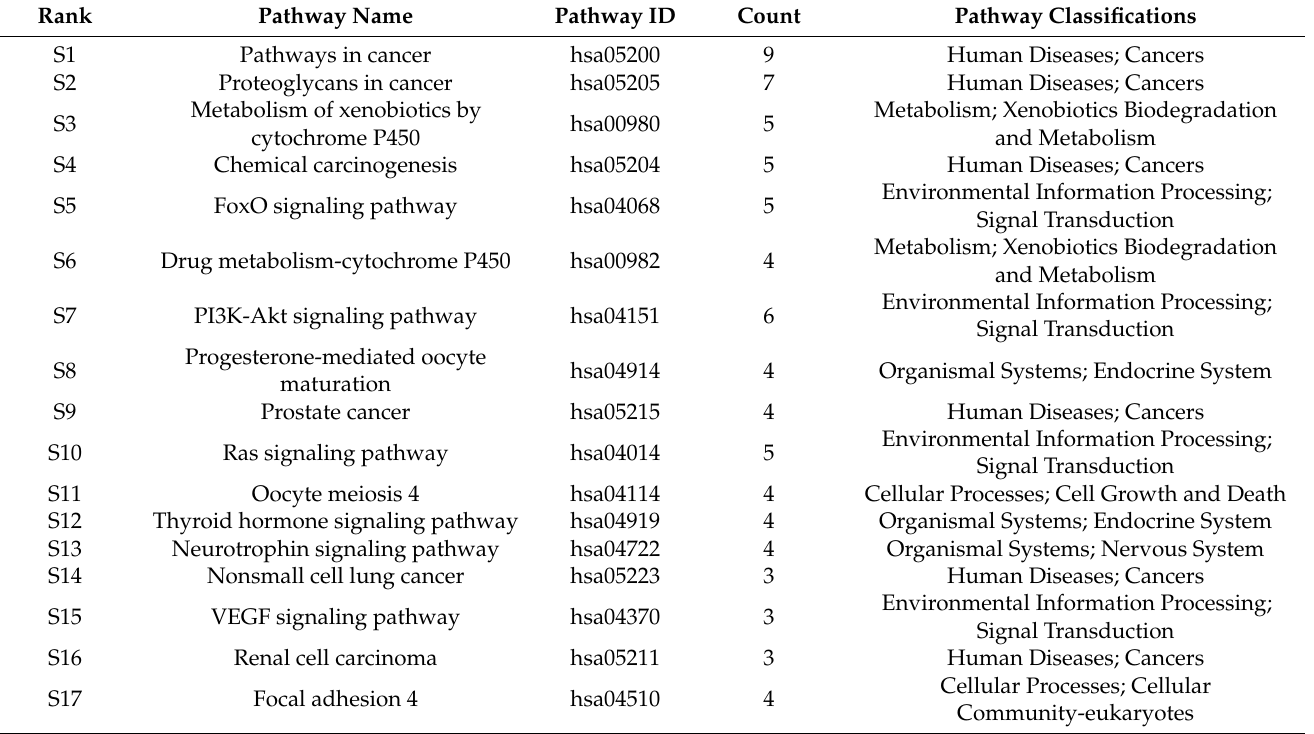
Table 5. Information of related pathways from 16 potential related-tumor targets in S. alopecuroides